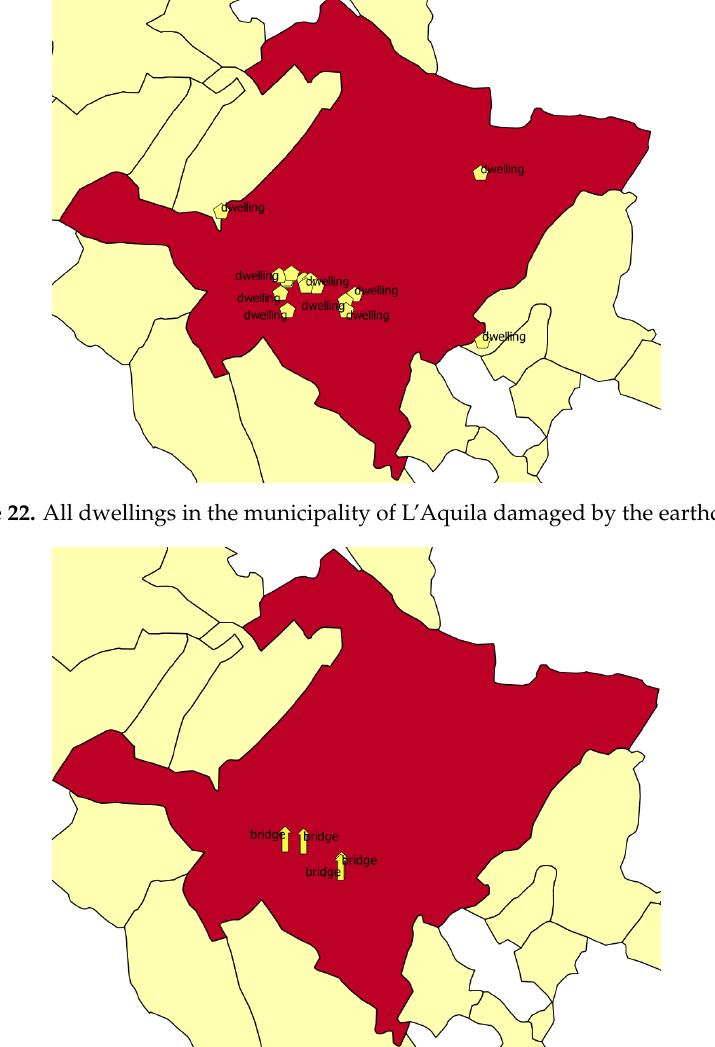
Figure 23. All targets in the municipality of L’Aquila damaged by the